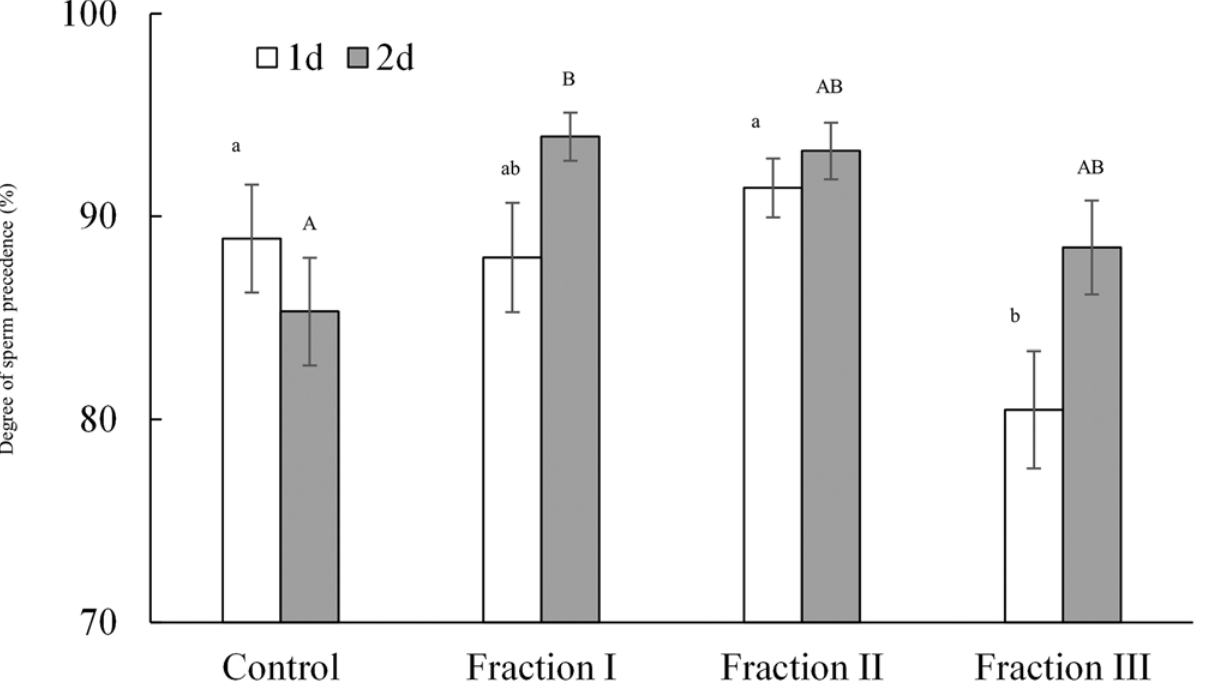
Fig 2. Competitive fertilization success of the second male to mate with females injected with extracts of male reproductive tracts. The figure shows the mean ( ± SE) degree of second male sperm precedence when females remated to a fertile focal male 1 or 2 days after first mating with a sterilized male. Females (N = 29 – 37 per day and treatment group) were injected with an aqueous solution of an extract of accessory glands (Fraction I [molecular weight: MW < 25 kDa], Fraction II [MW, 25 – 50 kDa], or Fraction III [MW > 50 kDa]) or with Milli-Q water only as a control. Identical letters indicate no significant difference by sequential Bonferroni post-hoc tests [48] at α = 0.05.